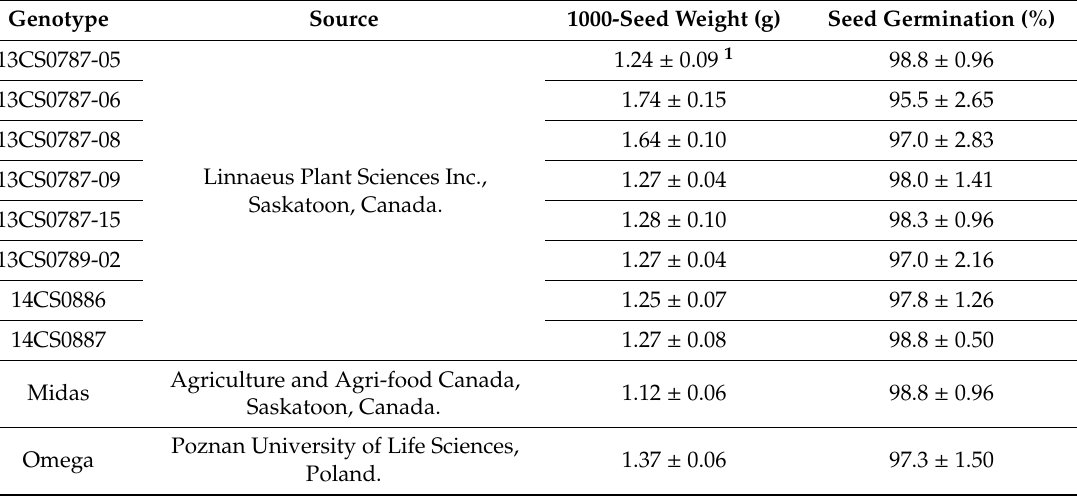
Table 1. Spring camelina genotypes tested in the experiment in